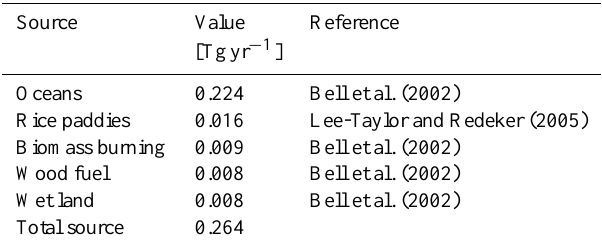
Table 1. Global source emission fluxes of CH 3 I used in MOZART- 3 3-D model to simulate background concentrations in the